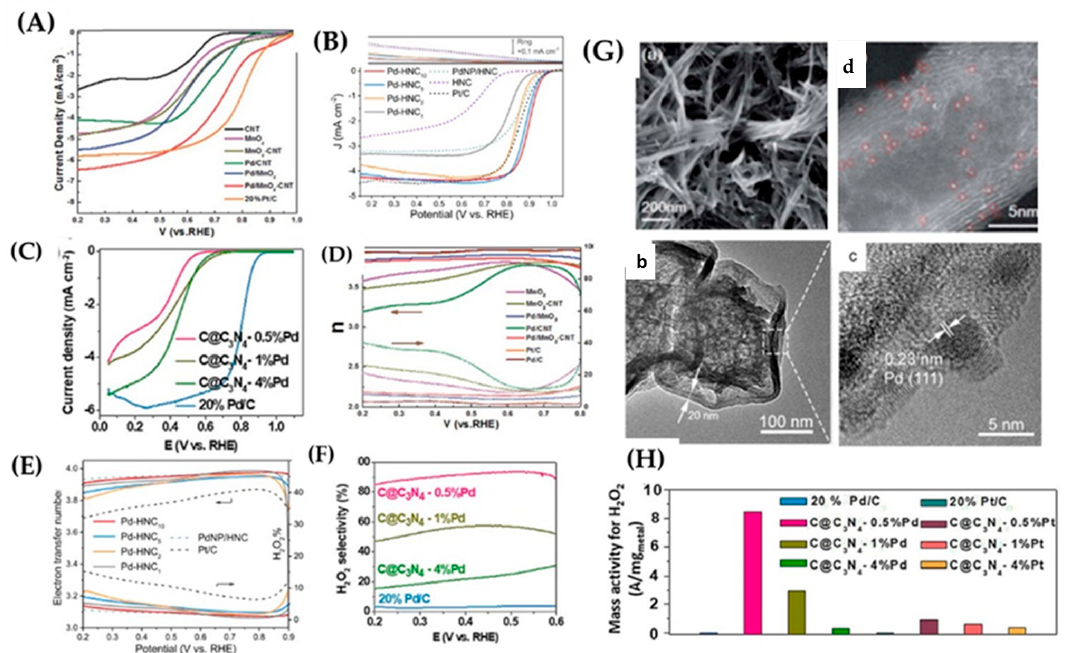
Figure 25. ORR linear sweep voltammetry curves on RDE in oxygen saturated cell of ( A ) MnO 2